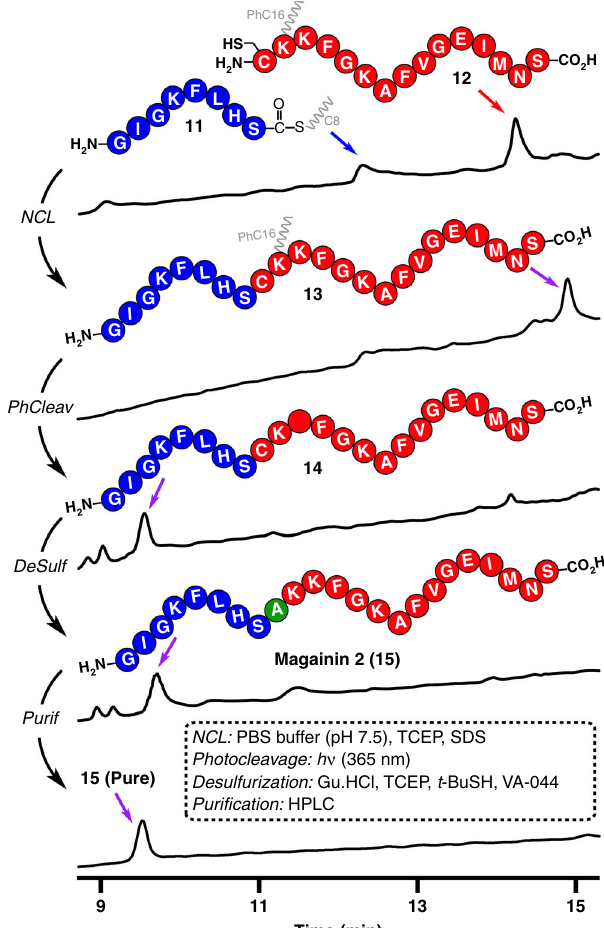
Fig. 4 One-pot strategy for the total synthesis of Magainin 2 (15). HPLC (210 nm) traces corresponding to the precursors, intermediates, and fi nal product. Retention times were veri fi ed by